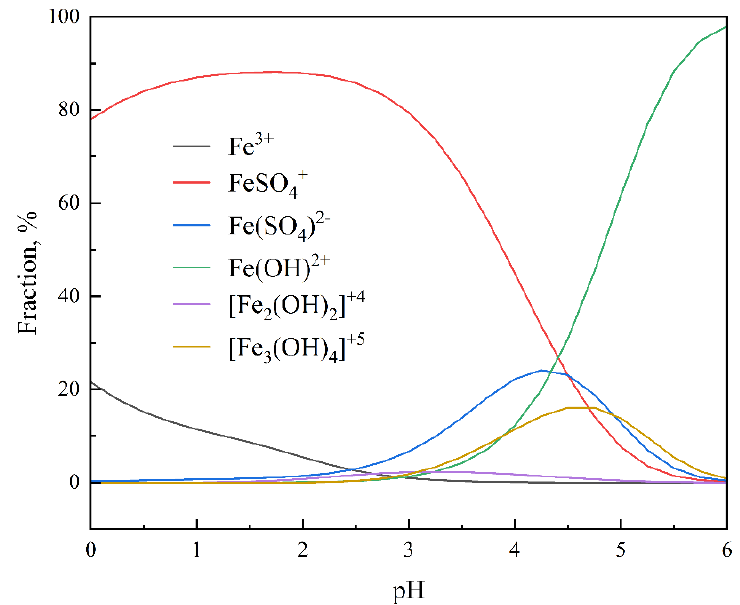
Figure 3. Iron species distribution in the leachate at various pHs under the conditions: [Fe 3+ ] = 12.25 Figure 3. g/L, [Cd 2+ ] = 23.28 g/L, [Ni 2+ ] = 56.30 g/L, and [Co 2+ ] = 0.52 g/L. [Fe 3+ ] = 12.25 g/L, [Cd 2+ ] = 23.28 g/L, [Ni 2+ ] = 56.30 g/L, and [Co 2+ ] = 0.52